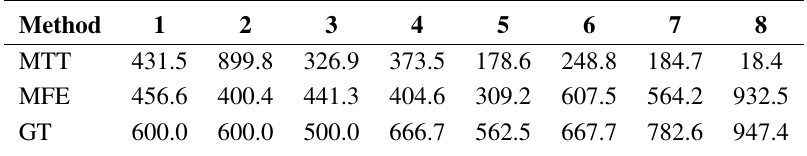
Table 2. Velocities calculated by multi-target tracking (MTT) and MFE (unit: cm/s). GT, ground